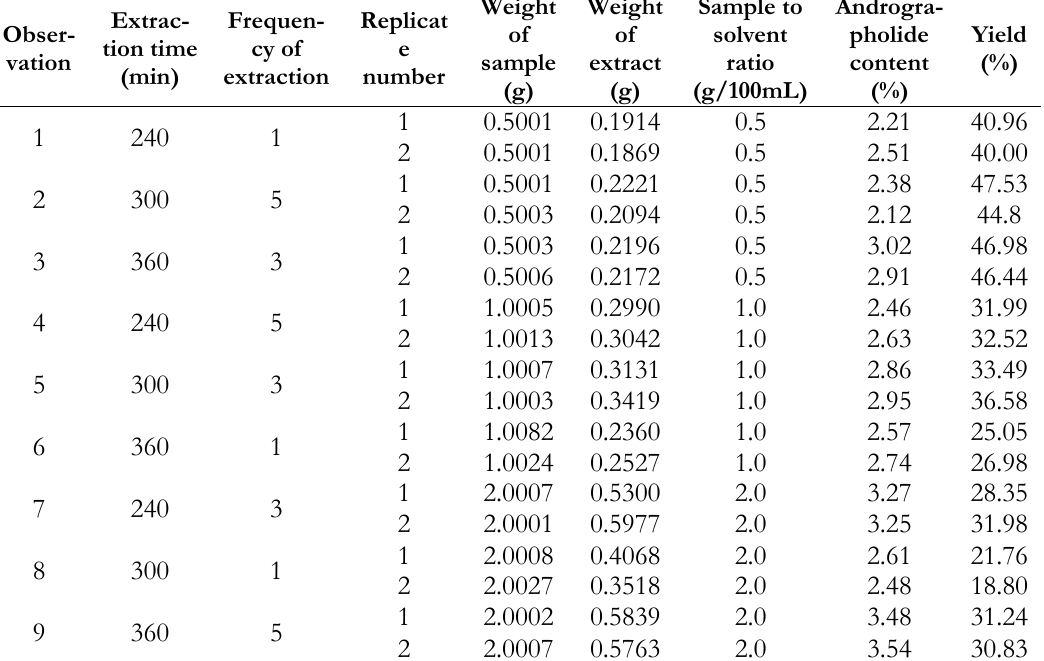
Table I. Fractional factorial design with 3 k-1 and the experimental result Obser- vation